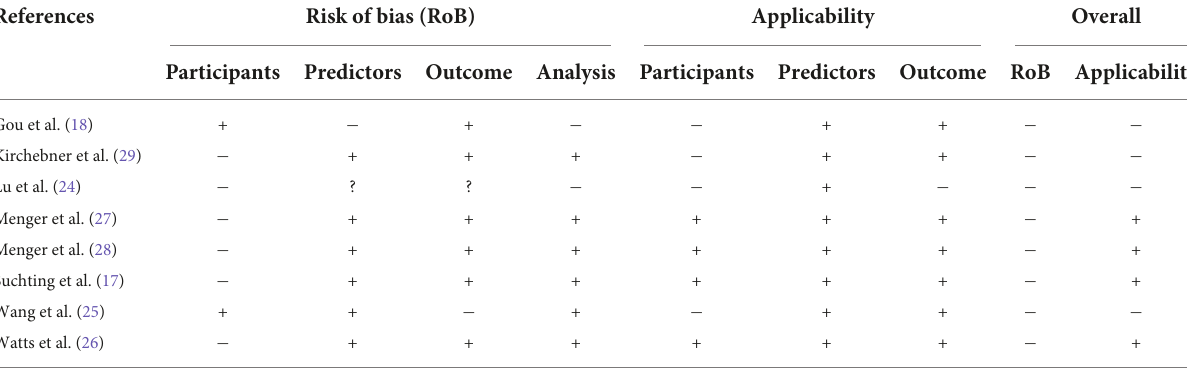
TABLE 3 Quality assessment through Prediction model Risk Of Bias ASsessment Tool